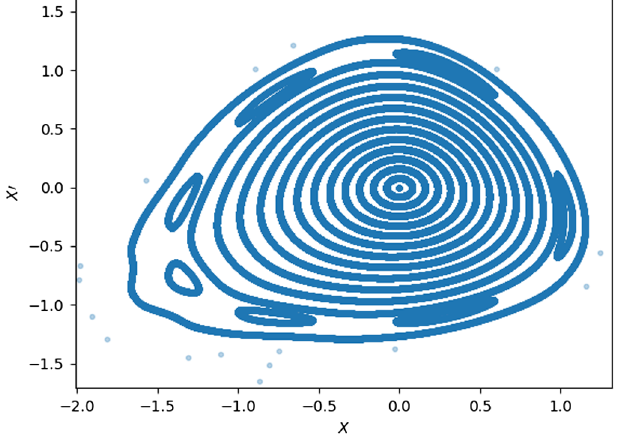
˜ M 3 (third-order uncoupled